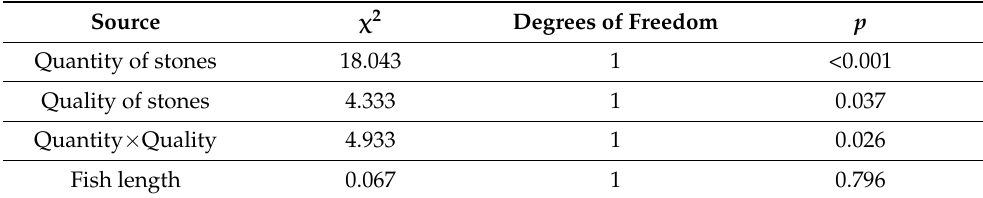
Table 1. Survival is influenced by an interaction between the quantity and quality of enrichments. Here, the results of generalized linear mixed model (GLMM) analysis on the survival of trout exposed to Flavobacterium columnare in tanks with different quantity (few/many) and quality (un- conditioned/conditioned) of stones are shown. The quantity and quality of the stones were used as fixed factors, the exposure tank as a random factor, and the fish length as a covariate.